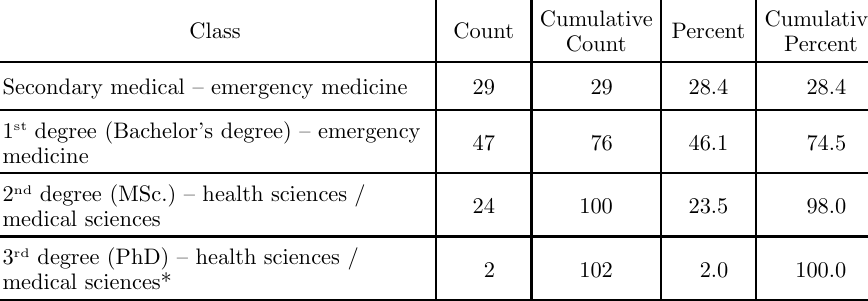
Table 2. Variables grouped on the basis of